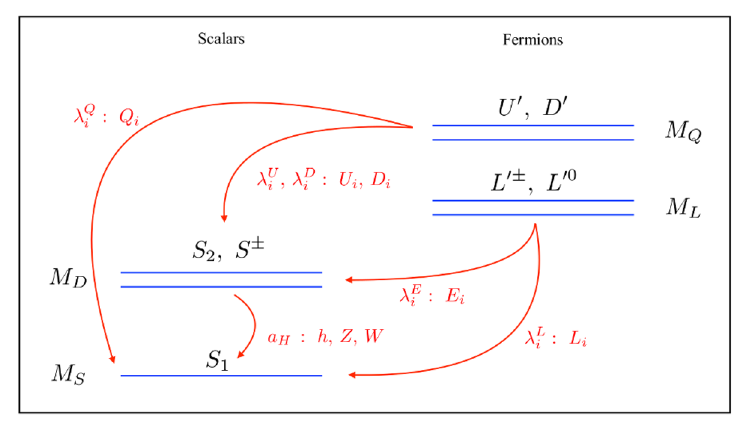
Figure 1 . Schematic representation of the new particles and